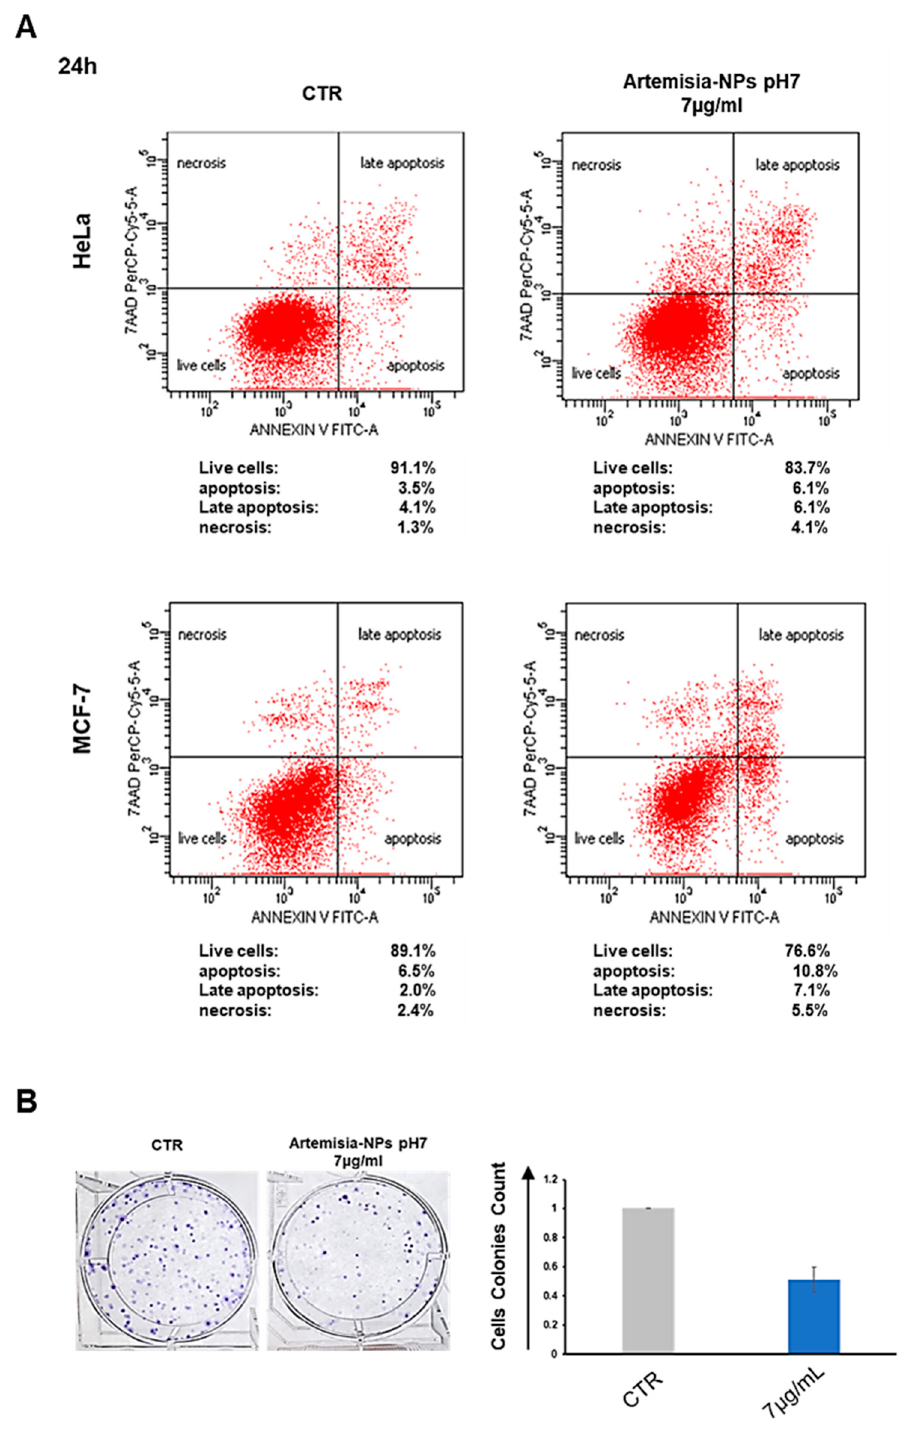
Figure 5. Apoptosis and cell colony formation assays. ( A ) Apoptosis/Necrosis assay. On the left control samples, while on the right samples treated with 7 µg/mL of Artemisia–AgNPs pH 7. Above HeLa cells and below MCF-7 cells. Cells were stained with Annexin V/7aad and analyzed by flow cytometry. ( B ) Clonogenic assay. After the formation of the first colonies, cells were treated with 7 µg/mL of Artemisia–AgNPs pH 7. Cell colonies were stained and counted.